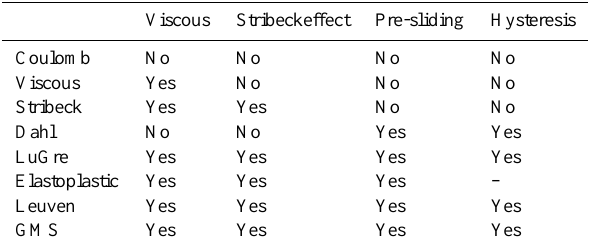
Figure 1. The working process of the PE-SSA.